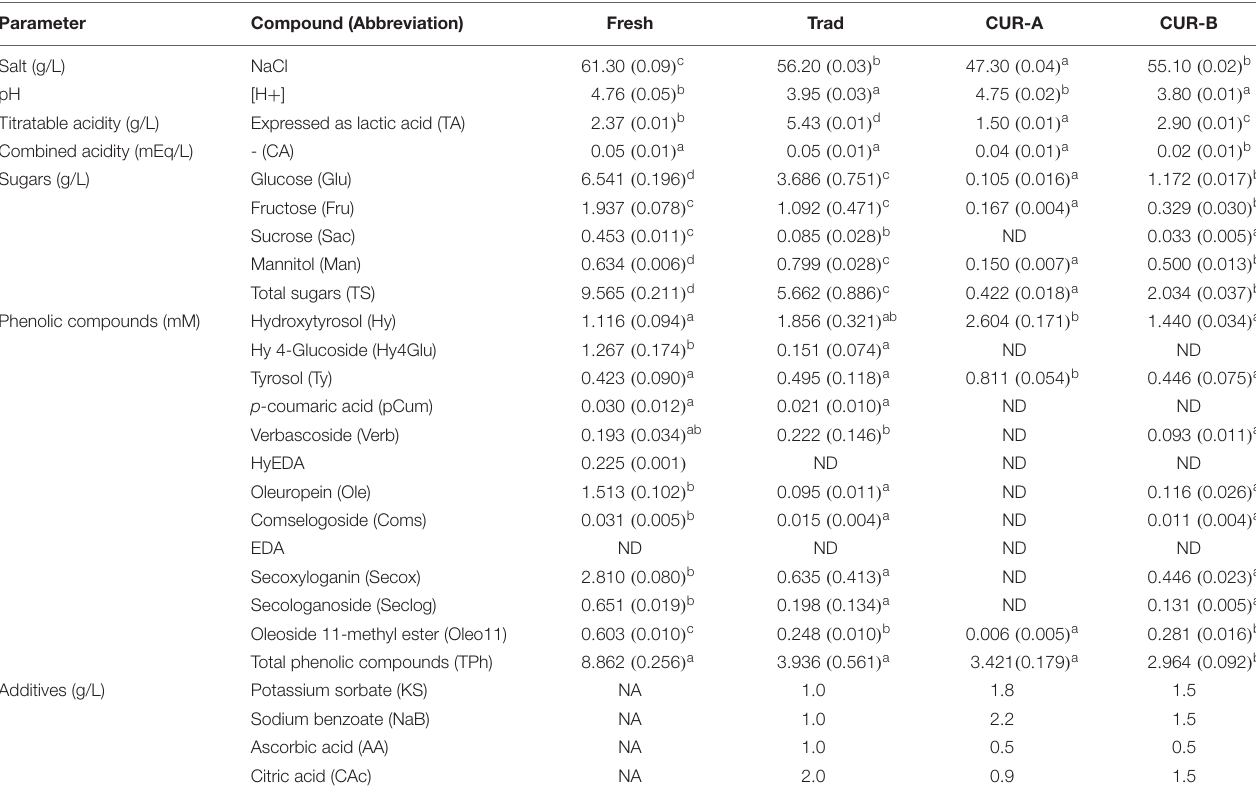
TABLE 1 | Physicochemical characteristics and additives levels of the different Aloreña de Málaga commercial packaging brines used in the present study.